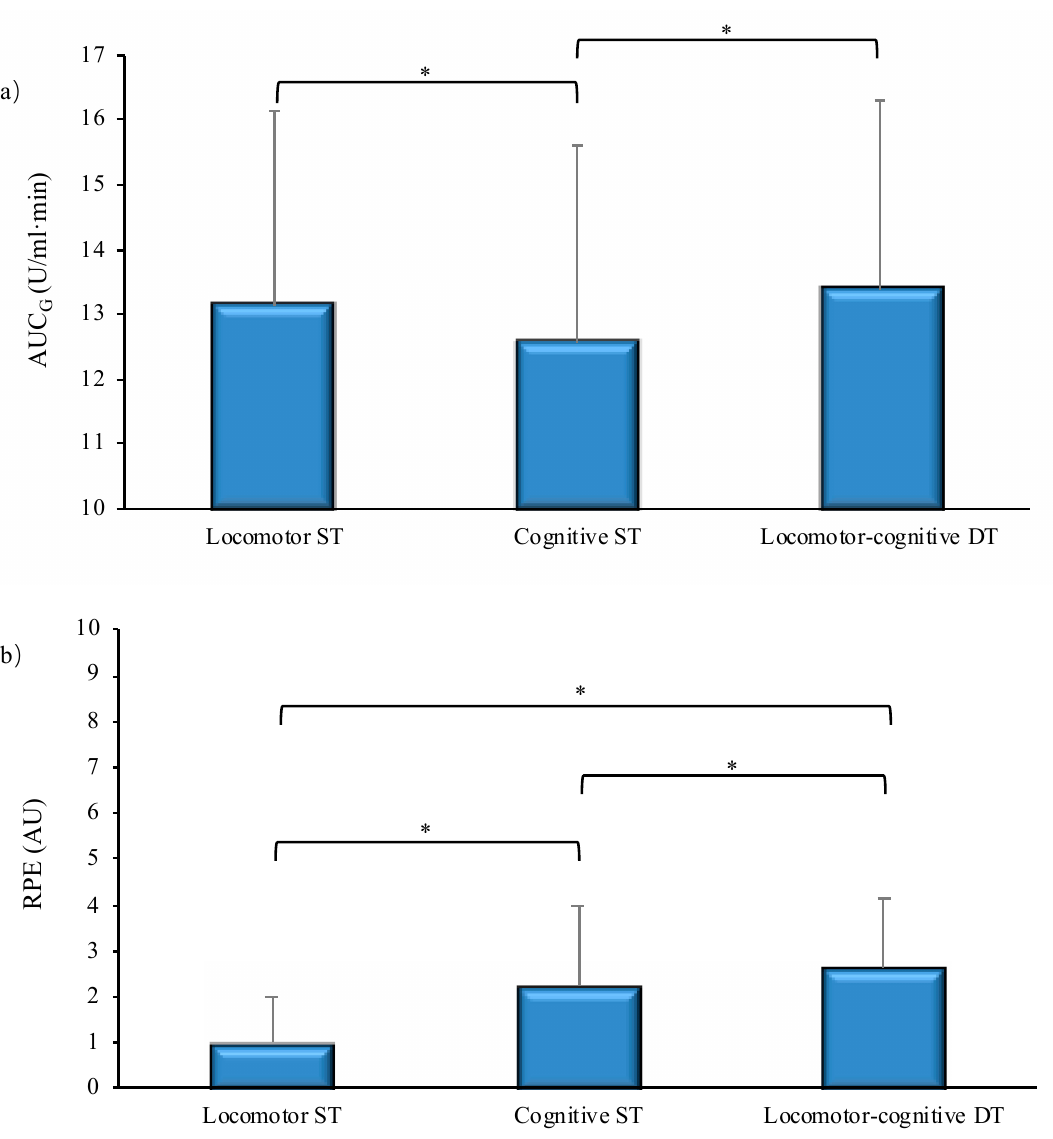
Figure 1. Di ff erences in salivary α -amylase (area under the curve with respect to ground, AUC G ; panel a ) and Rating of Perceived Exertion (RPE; panel b ) among the three task conditions. Locomotor ST = walking task at habitual walking speed (HWS). Cognitive ST = Random Number Generation (RNG) task. Locomotor-cognitive DT = walking at HWS while performing the RNG task. * p < 0.05.